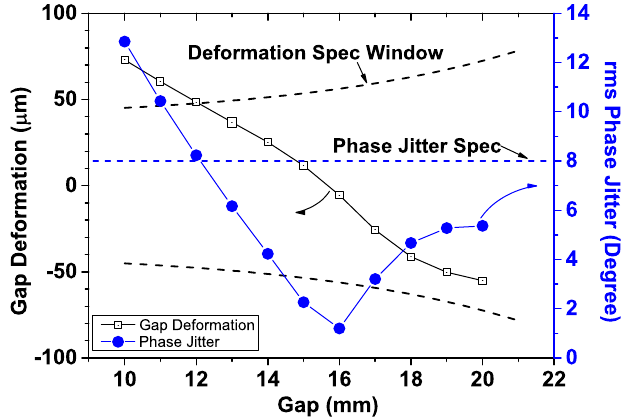
FIG. 10. Effect of shifting the tuning gap to 16 mm on gap deformation (open squares) and the rms phase jitter (full circles) as a function of the undulator gap. Now at 20 mm specifications are fulfilled but exceeded at small